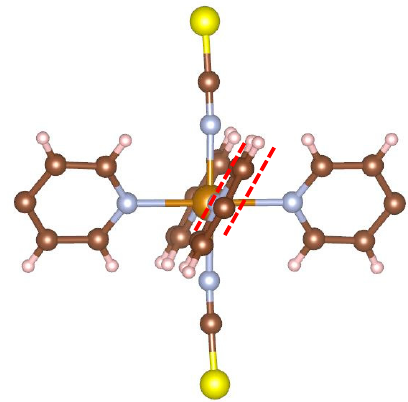
Figure 5. The local structure around the iron of complex 1 . Coordinated pyridine planes are parallel.